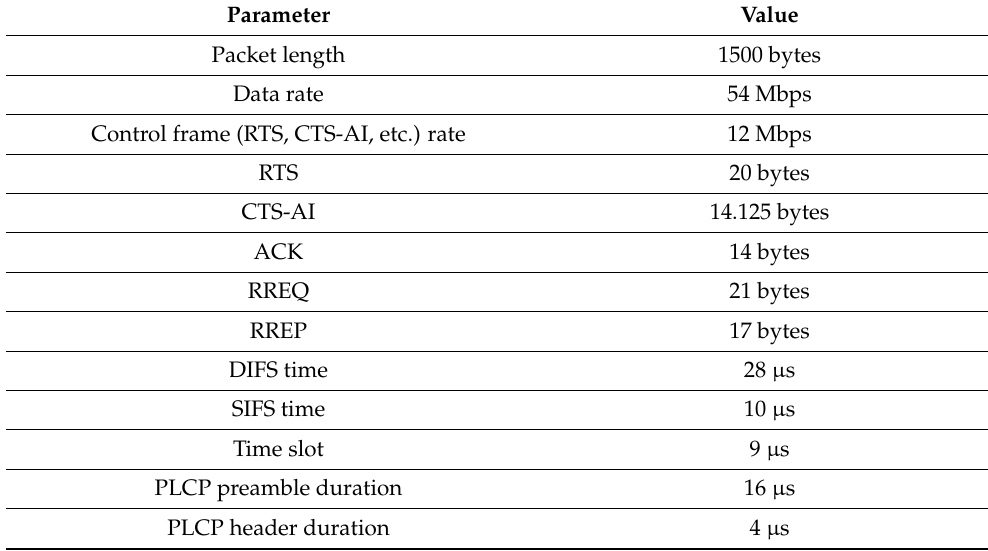
Table 2. Declaration of